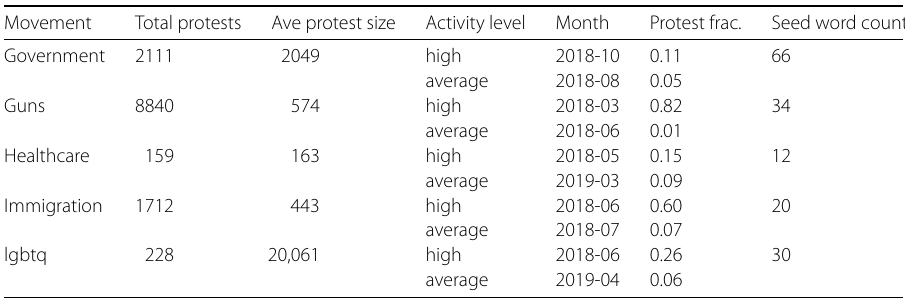
Table 1 Summary Stats for Sampled Movement Movement Total protests Ave protest size Activity level Month Protest frac. Seed word count Government 2111 2049 high